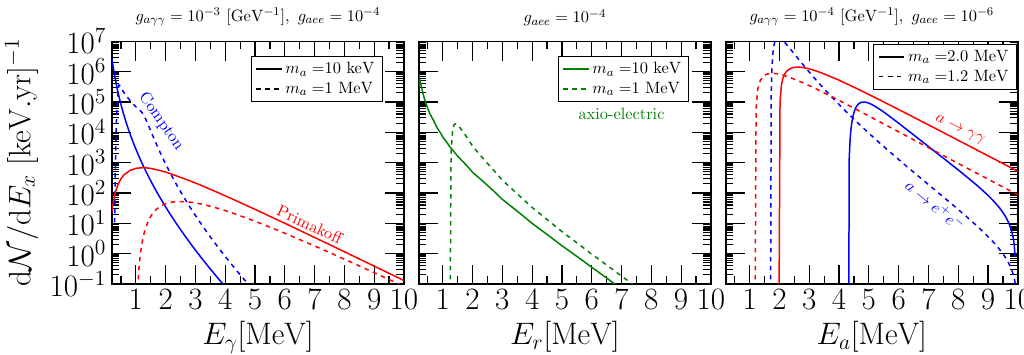
Figure 8 . Differential event rate for Compton-like and Primakoff scattering (left graph), axio-electric absorption (middle graph) and ALP decay to electron-positron and photon pairs (right